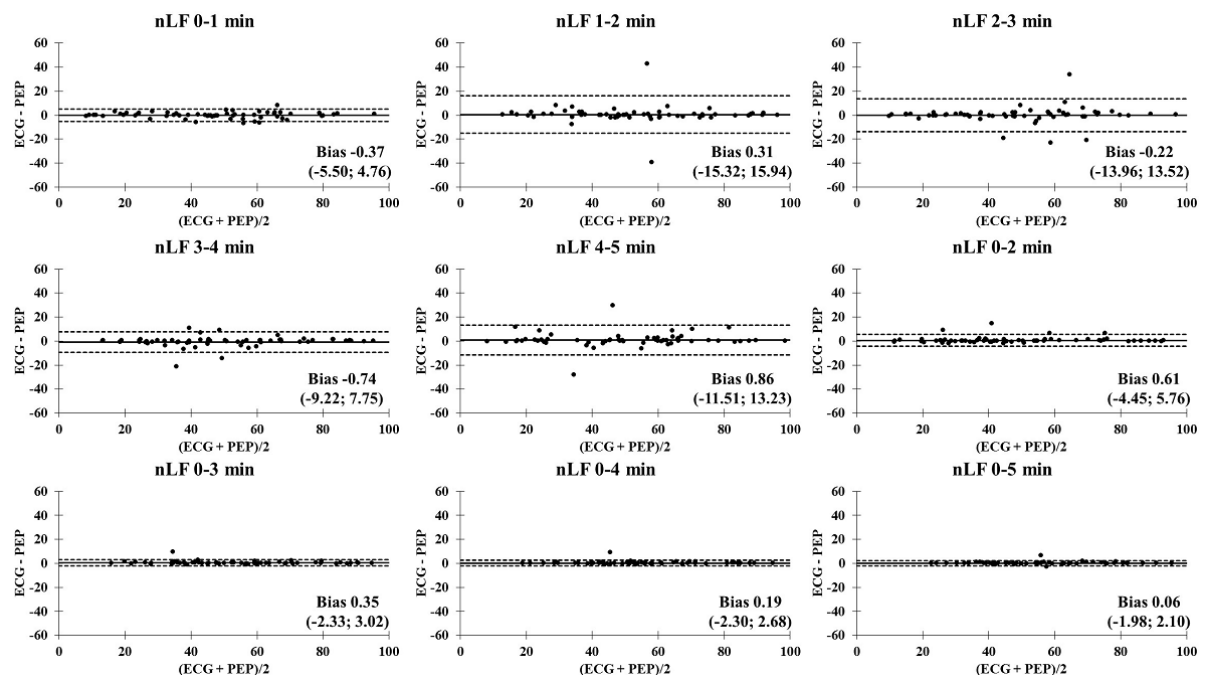
Figure 8. Bland-Altman analysis comparing the ECG and Pulse Express PRO measurements in ultra–short-term and short-term recordings of normalized low frequency power (nLF). The solid line represents the mean difference and the upper and lower dashed lines represent the upper and lower limits of agreement (± 1.96*SD). ECG: electrocardiogram; PEP: Pulse Express PRO.